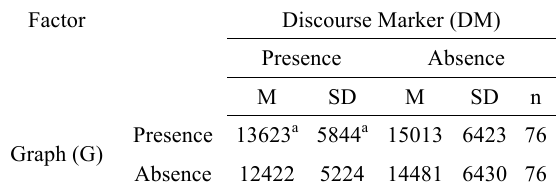
Table 3. Mean and Standard Deviation for Fixation Time on the consequence segment (S2).